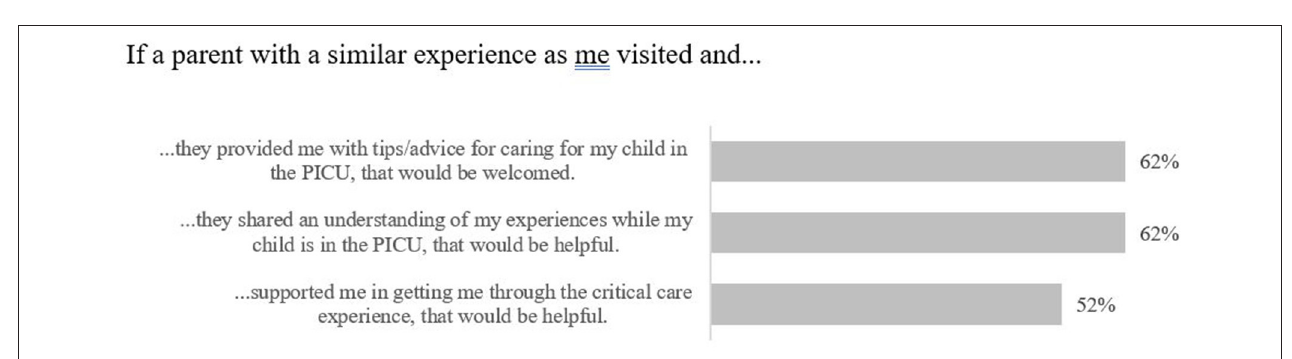
FIGURE 11 | Family level of agreement in PICU experience statements (peer mentor, pre-survey).